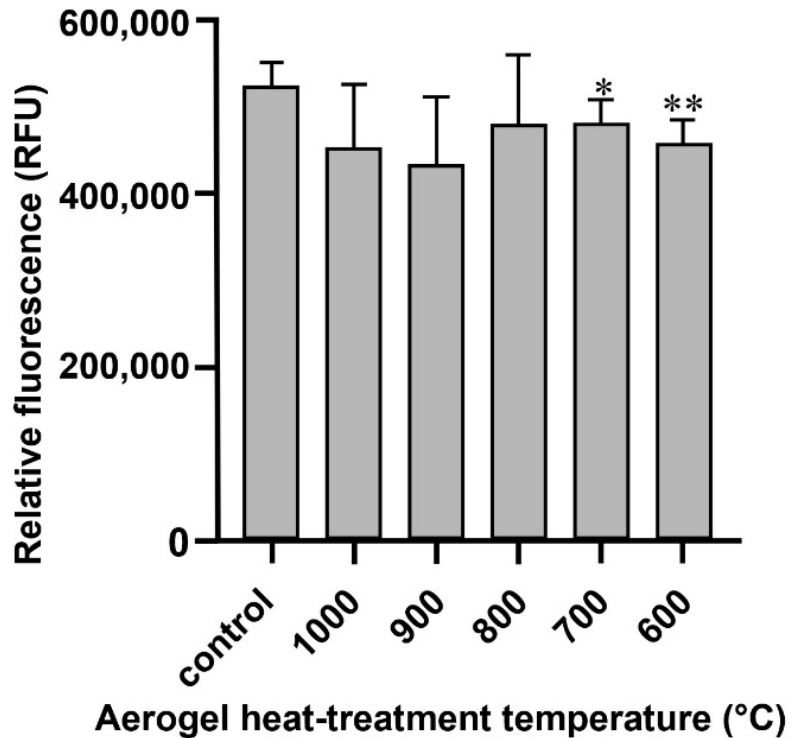
Figure 8. The effects of the differently heat-treated aerogel composites on the viability of MG63 cells cultured for 14 days as measured by the Alamar Blue assay. Values are expressed as sample means; error bars represent the estimates of standard deviations calculated from three parallel measurements compared to the control (* p < 0.05, ** p < 0.01).